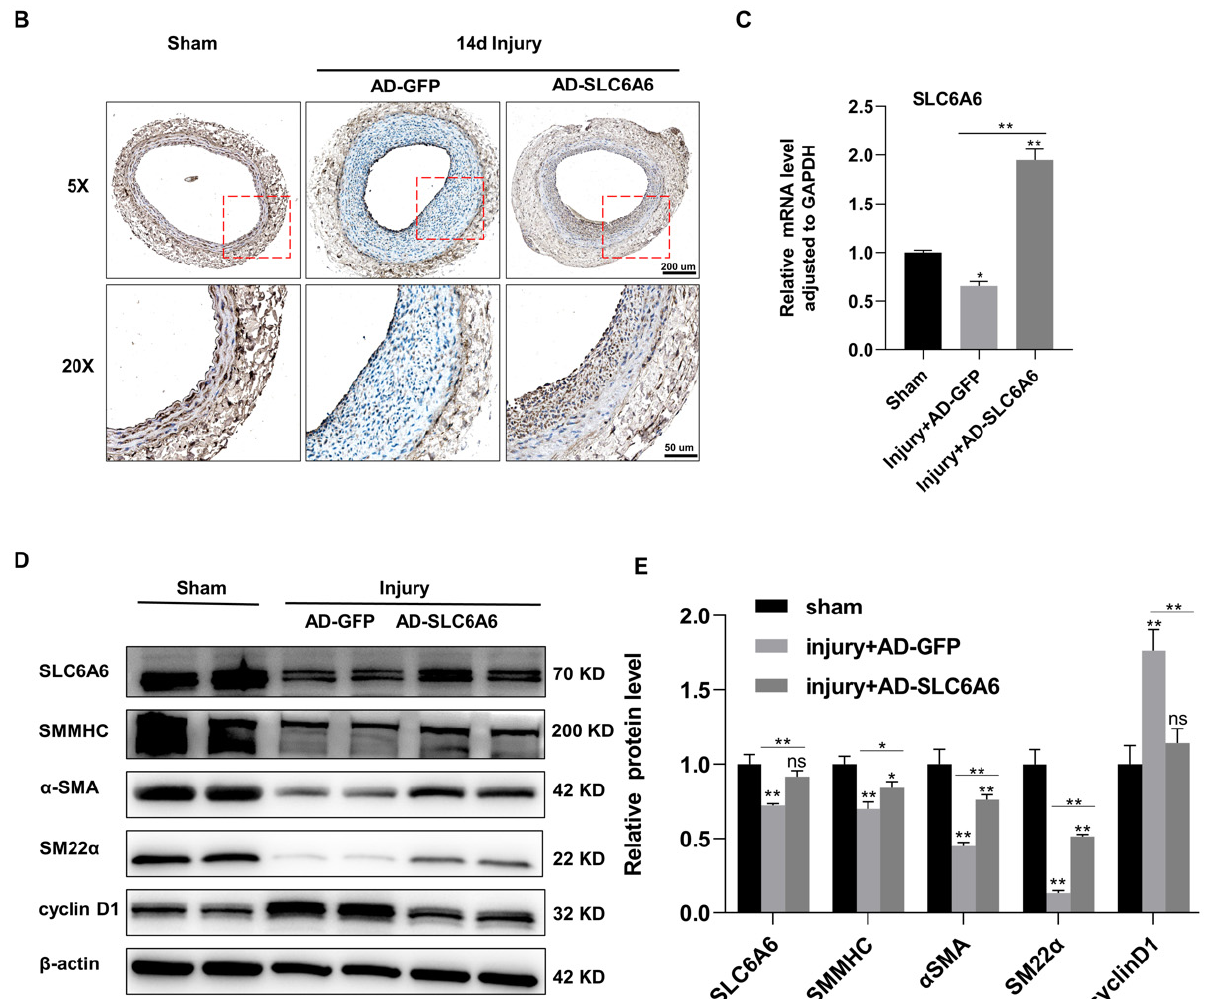
Figure 7. Local SLC6A6 overexpression in vivo ameliorated neointimal formation after vascular in‑ jury. ( A ) Representative HE stained in sham group and injured carotid arteries treated with AD‑GFP or AD‑SLC6A6 for 14 days after injury. Scale bar: 200 µ m (50 × upper). Scale bar: 50 µ m (200 × lower). Quantitative analysis of the intima area, media area, and the ratio of intima to media and media area. N = 6; ns, not significant; * p < 0.05, ** p < 0.01 vs. AD‑GFP; data are represented as mean ± SD. ( B ) Representative cross‑sections of immunohistochemically stained SLC6A6 (brown) in carotid arter‑ ies treated with AD‑GFP or AD‑SLC6A6 for 14 days after injury. Scale bar: 200 µ m (50 × upper). Scale bar: 50 µ m (200 × lower). ( C ) The mRNA level of SLC6A6 in sham group and injured carotid arteries treated with AD‑GFP or AD‑SLC6A6 for 14 days after injury. Data are normalized to GAPDH. N = 6; ns, not significant; * p < 0.05, ** p < 0.01 vs. sham; data are represented as mean ± SD. ( D , E ) Western blot analysis of SLC6A6, contractile VSMC-specific proteins (SMMHC, α SMA, SM22 α ) and cell proliferation marker cyclin D1 in sham group, and injured carotid arteries treated with AD-GFP or AD-SLC6A6 for 14 days after injury. Data are normalized to β -actin. N = 6; ns, not significant; * p < 0.05, ** p < 0.01; label *, **, ns on the bars compares with sham group. Data are represented as mean ± SD.